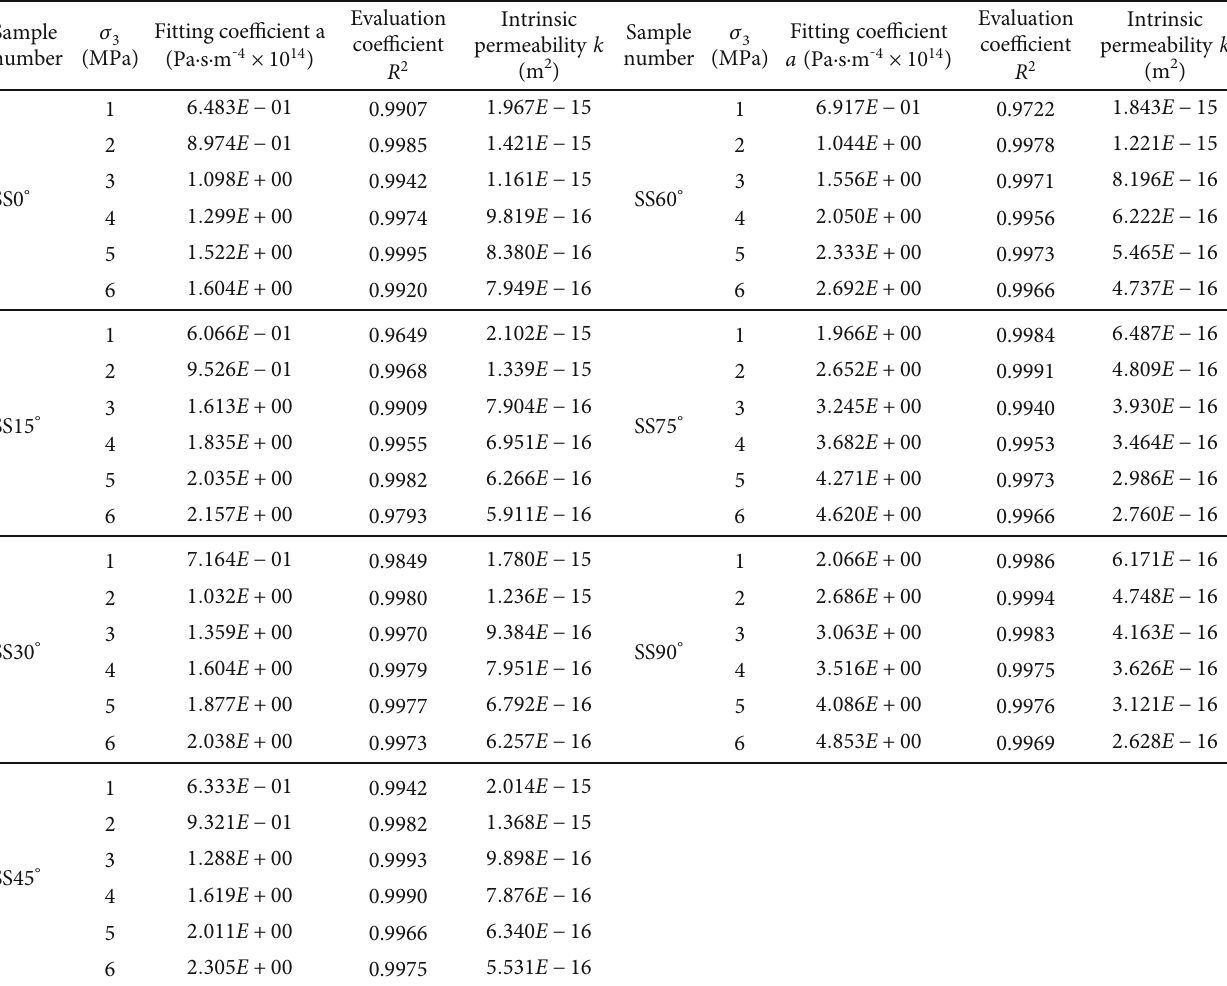
Table 2: Fitting results of the linear Darcy ’ s law equation and calculated values of k